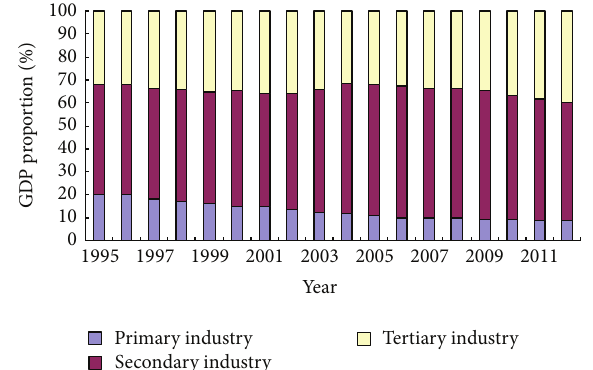
Figure 2: Industrial structure of Shandong province from 1995 to 2012. Source: Shandong Statistics Yearbook